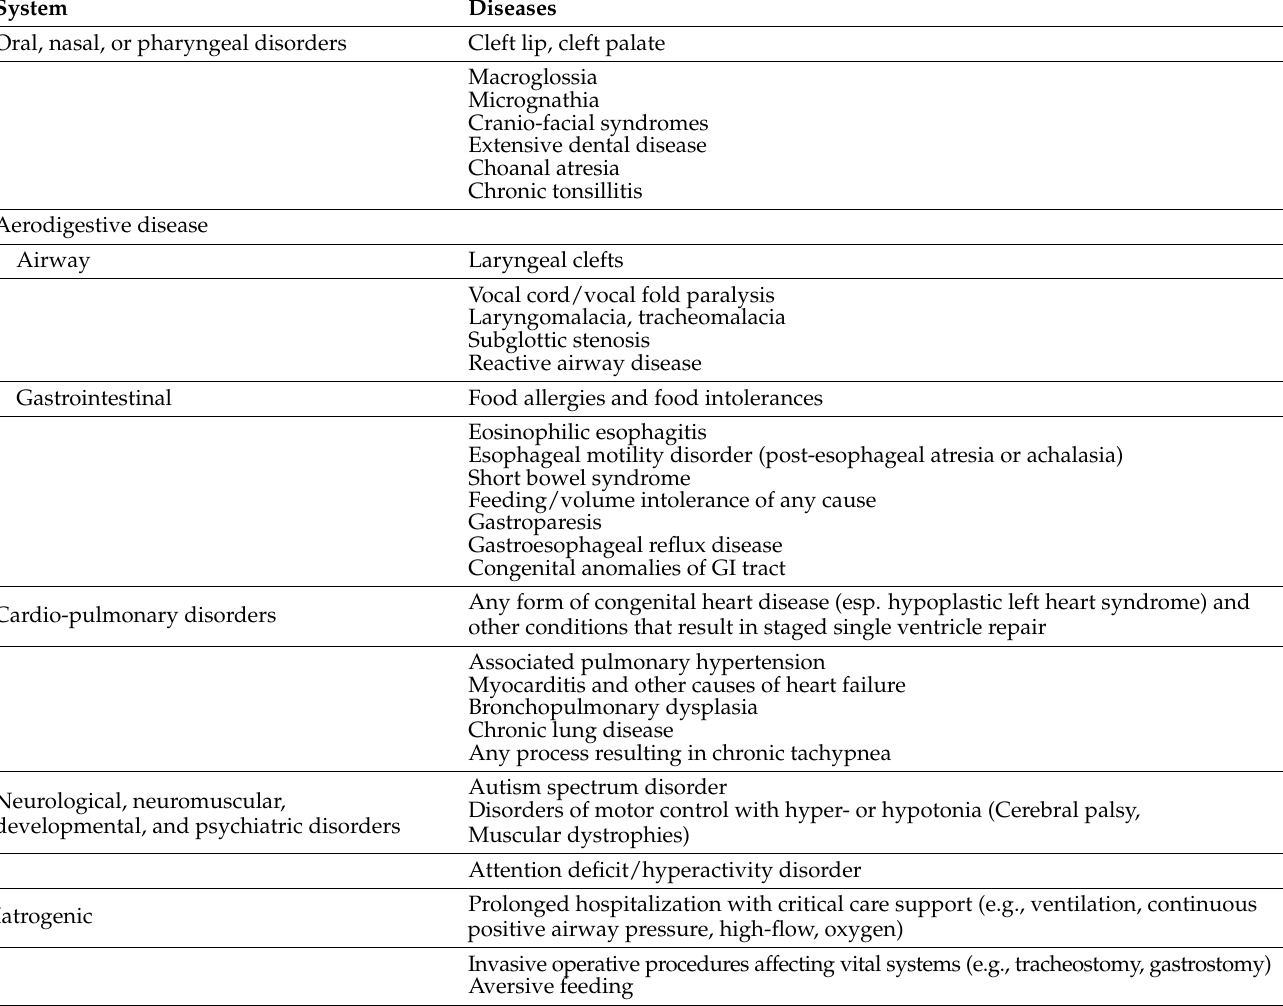
Table 2. Medical conditions associated with Pediatric Feeding